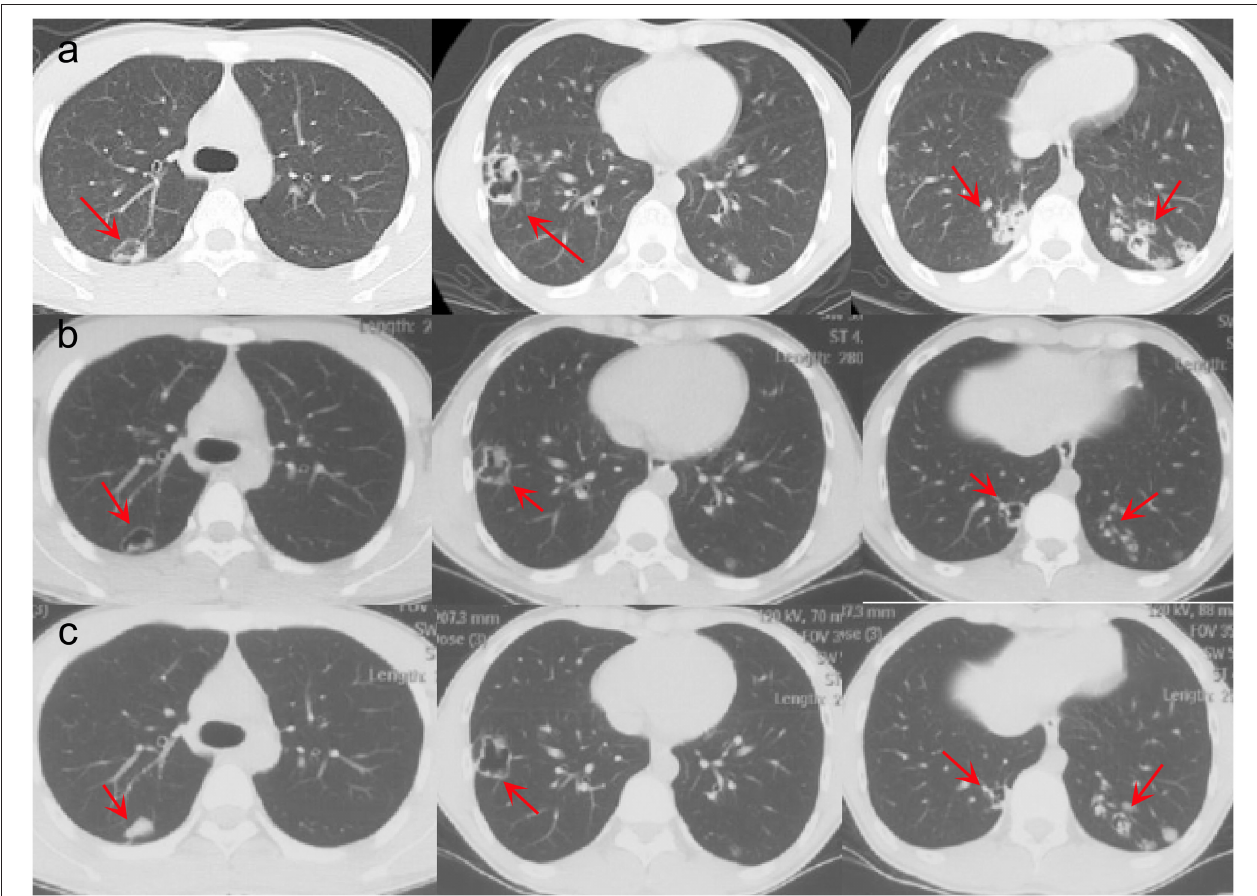
FIGURE 1 | Pre- and post-therapy CT scan. (a) Chest CT before treatment. (b) Chest CT after cefotaxime sodium sulbactam treatment. (c) Chest CT after voriconazole